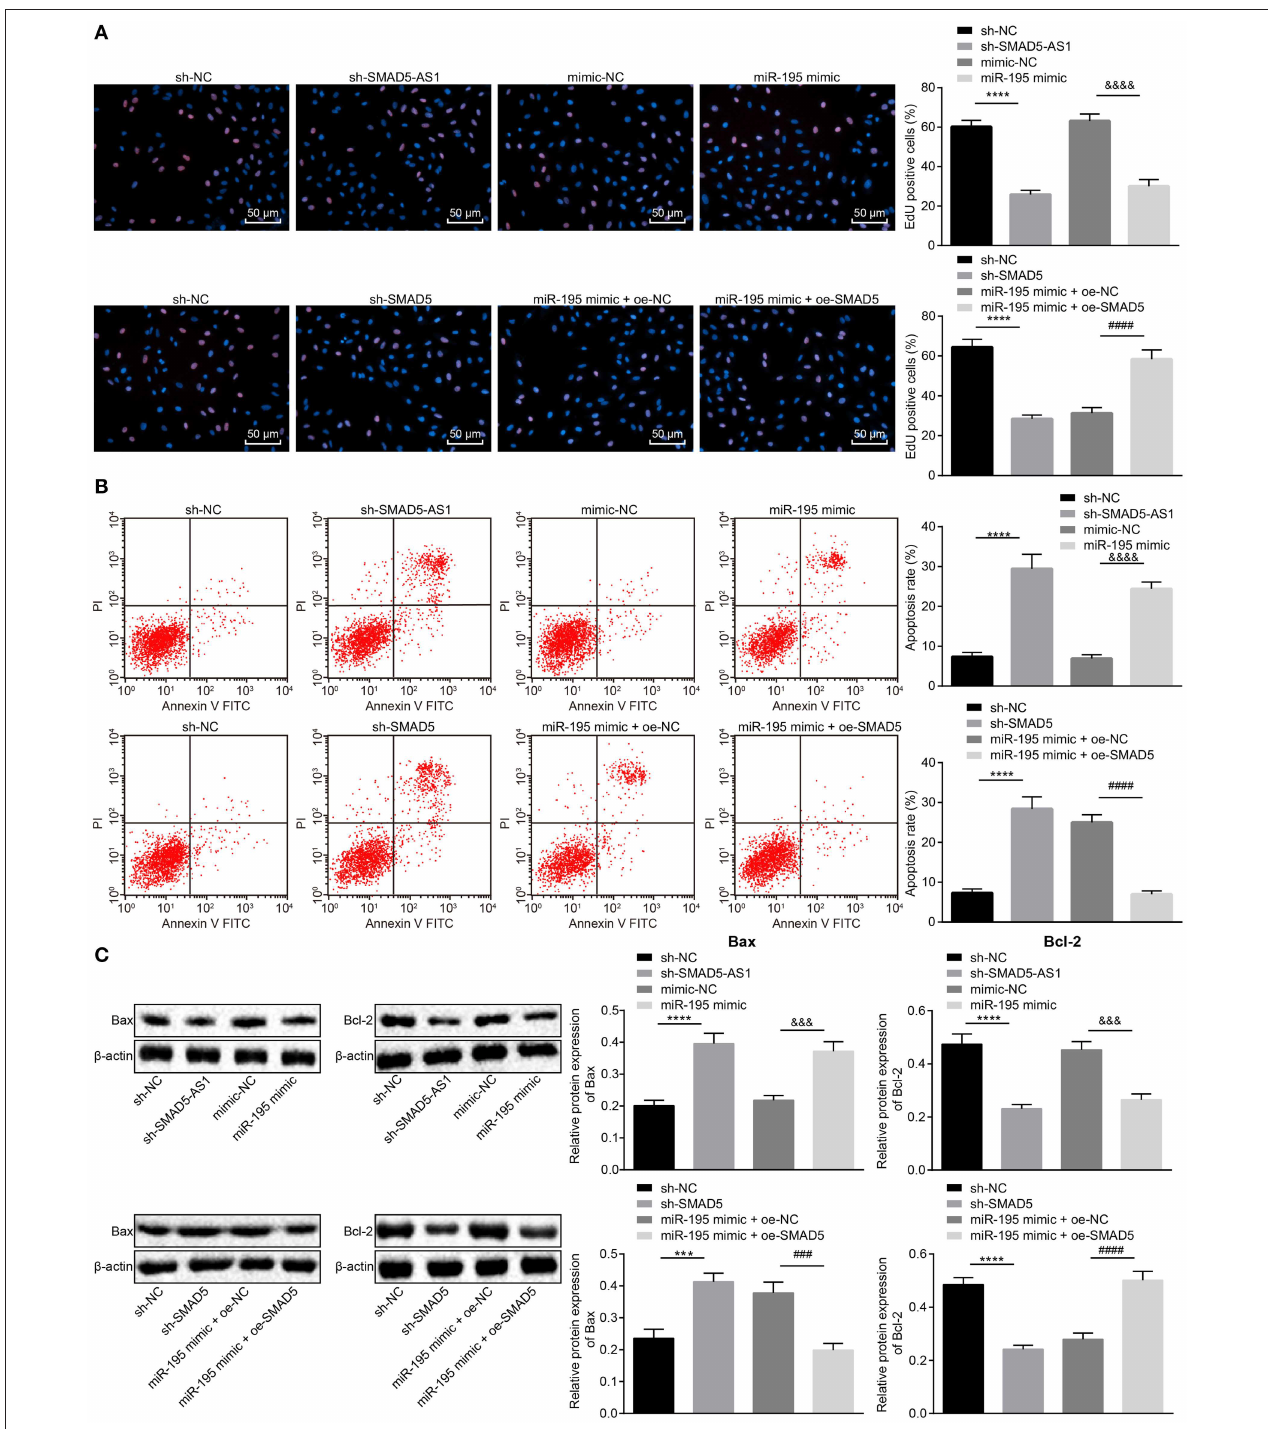
FIGURE 4 | CNE-2 cell proliferation was suppressed while cell apoptosis was enhanced following knockdown of SMAD5-AS1 or SMAD5 or elevation of miR-195. (A) CNE-2 cell proliferation assessed by EdU assay (200 × , scale bar = 50 um). (B) CNE-2 cell apoptosis rate measured using flow cytometry. In (A,B) , **** p < 0.0001 vs. the sh-NC group; &&&& p < 0.0001 vs. the mimic-NC group; #### p < 0.0001 vs. the miR-195 mimic + oe-NC group. (C) The protein expression of apoptosis-related factors Bax and Bcl-2 in CNE-2 cells determined by western blot analysis. **** p < 0.0001 vs. the sh-NC group; *** p < 0.001 vs. the sh-NC group; &&& p < 0.0001 vs. the mimic-NC group; #### p < 0.0001 vs. the miR-195 mimic + oe-NC group; ### p < 0.001 vs. the miR-195 mimic + oe-NC group. The data were measurement data and depicted as mean ± standard deviation. Data between two groups were tested using independent sample t -test. The experiment was repeated 3